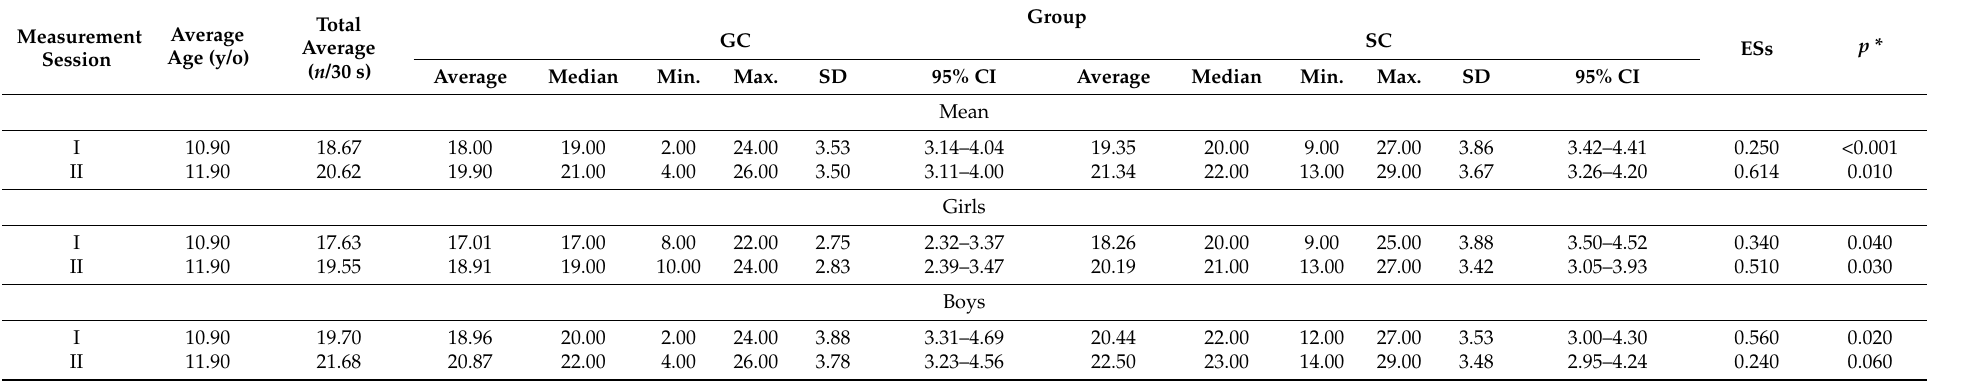
Table 1. Results of the core strength test, number of sit-ups in 30